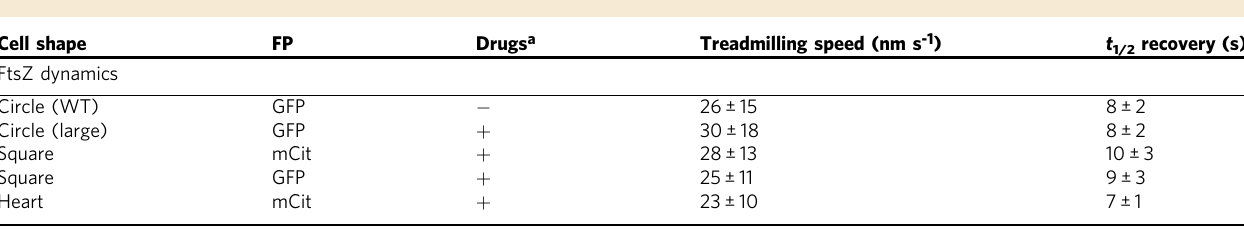
Table 2 Summary of FtsZ dynamics in various cell shapes Cell shape